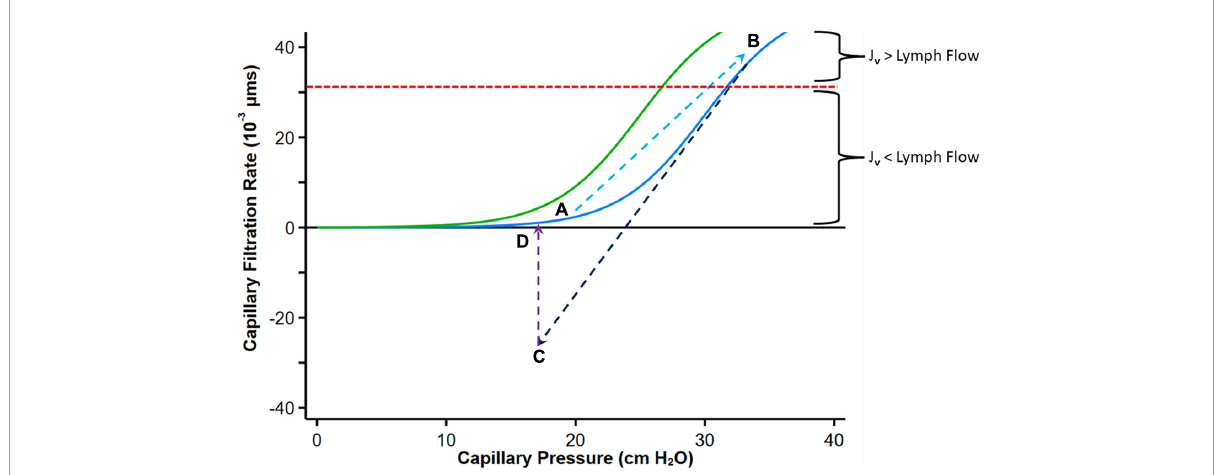
FIGURE5 Graph depicting fluid exchange (filtration or absorption rate, J v ) across the capillary wall as a function of capillary pressure. Point A represents a normal steady state position with minimal filtration. With heart failure decompensation, fluid and salt retention cause an increase in mean capillary pressure, leading to an increase in fluid absorption into the interstitial compartment and a reduction in plasma COP which shifts the curve to the left (Green curve, Point B). Diuretic therapy reduces capillary pressure with reversal to fluid absorption into the intravascular compartment (Point C). If diuresis is brief, the absorption rate falls and can move again toward Point B. Fluid uptake into the intravascular compartment has a variable effect on plasma protein concentration depending on the relative rates of diuresis and plasma refill rates. When diuresis increases the interstitial COP, the colloid osmotic pressure difference declines and reduces absorption of fluid into the capillaries (Point D). The red dashed line indicates the point where the maximal removal capacity of lymph flow cannot compensate for the increased capillary filtration. Modified from references (61, 65, 66). See text for